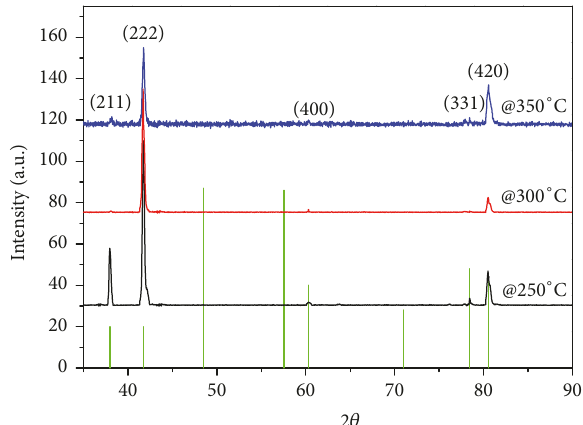
Figure 7: X-ray diffraction patterns of CdO thin films prepared at 250, 300, and 350 ∘ C.